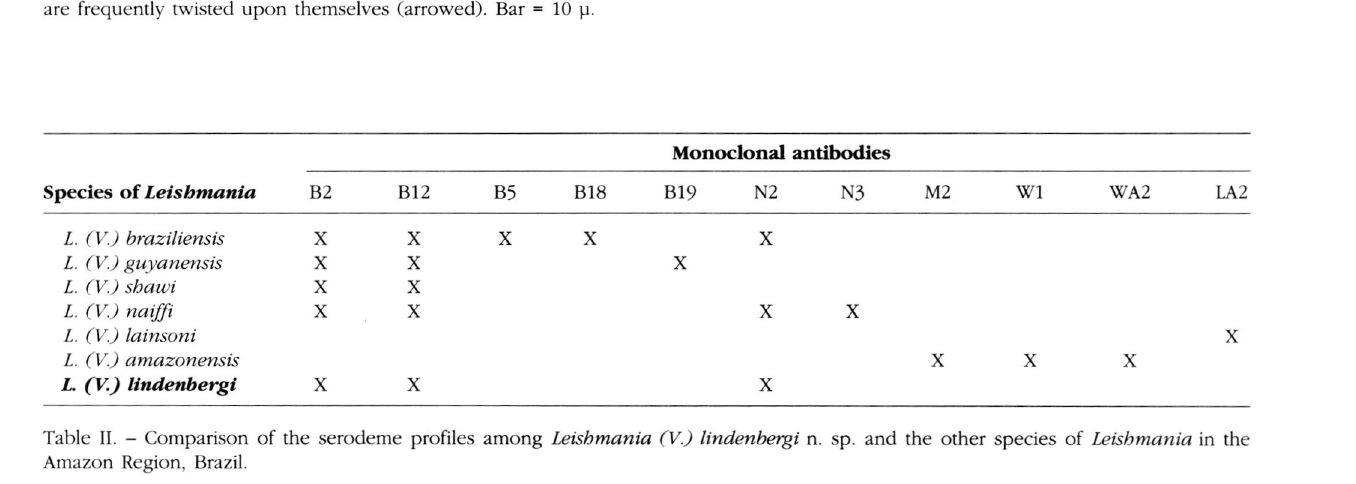
Monoclonal antibodies